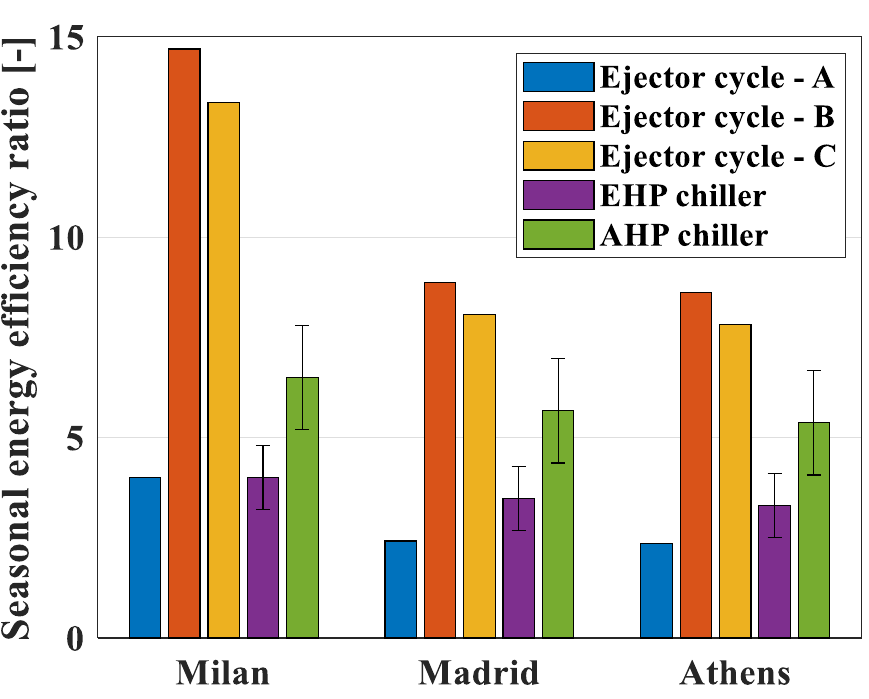
Figure 8. Seasonal performance comparison between hybrid ejector cycle and current technology. In order to give a complete scenario, an economic analysis was proposed by con- sidering both the investment and running costs. The set-up costs for the hybrid ejector cycle were obtained by considering each component as previously described, whereas the investment costs for electrical and absorption chillers were evaluated from a market analysis perspective [23], as detailed in Table 6. The running costs were evaluated with Equation (18): a lifetime of 20 years and three different values for the electricity-specific price (0.10, 0.30, 0.50 € /kWh) were considered.